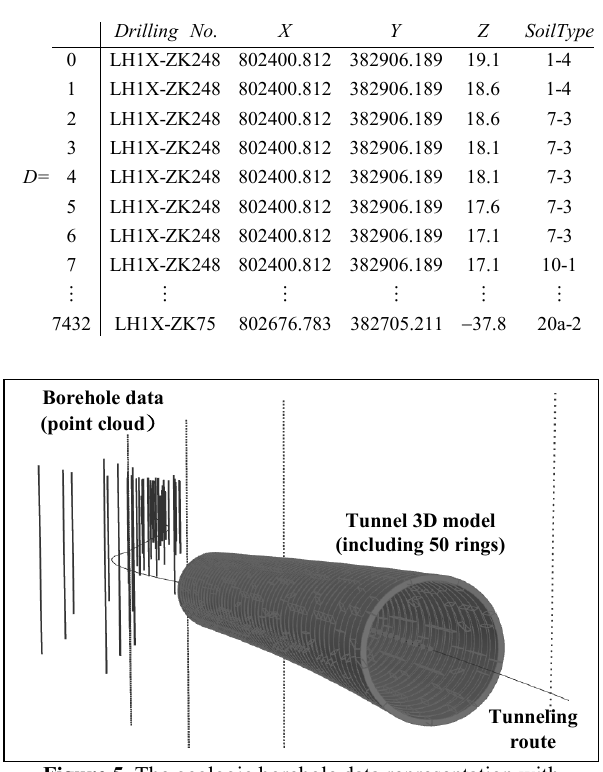
Figure 5 . The geologic borehole data representation with tunnel